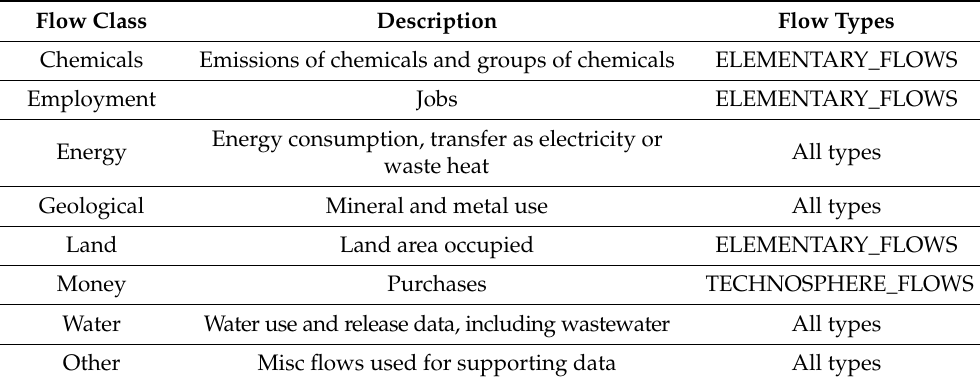
Table 1. Flow classes present in FLOWSA v1.2.1.